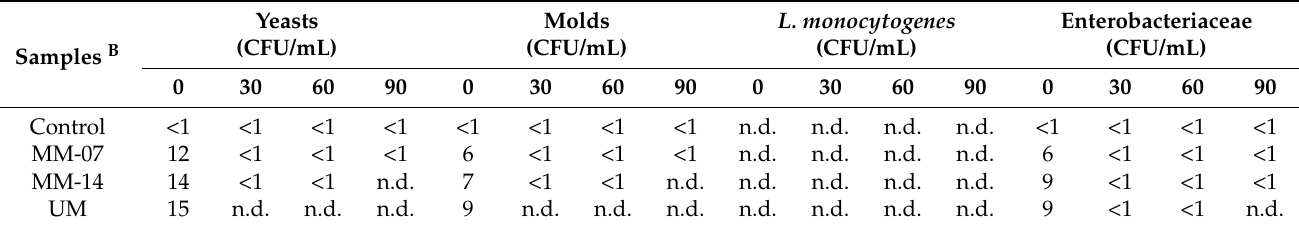
Table 5. Microorganism colonies in SFO samples during 90-day storage A .